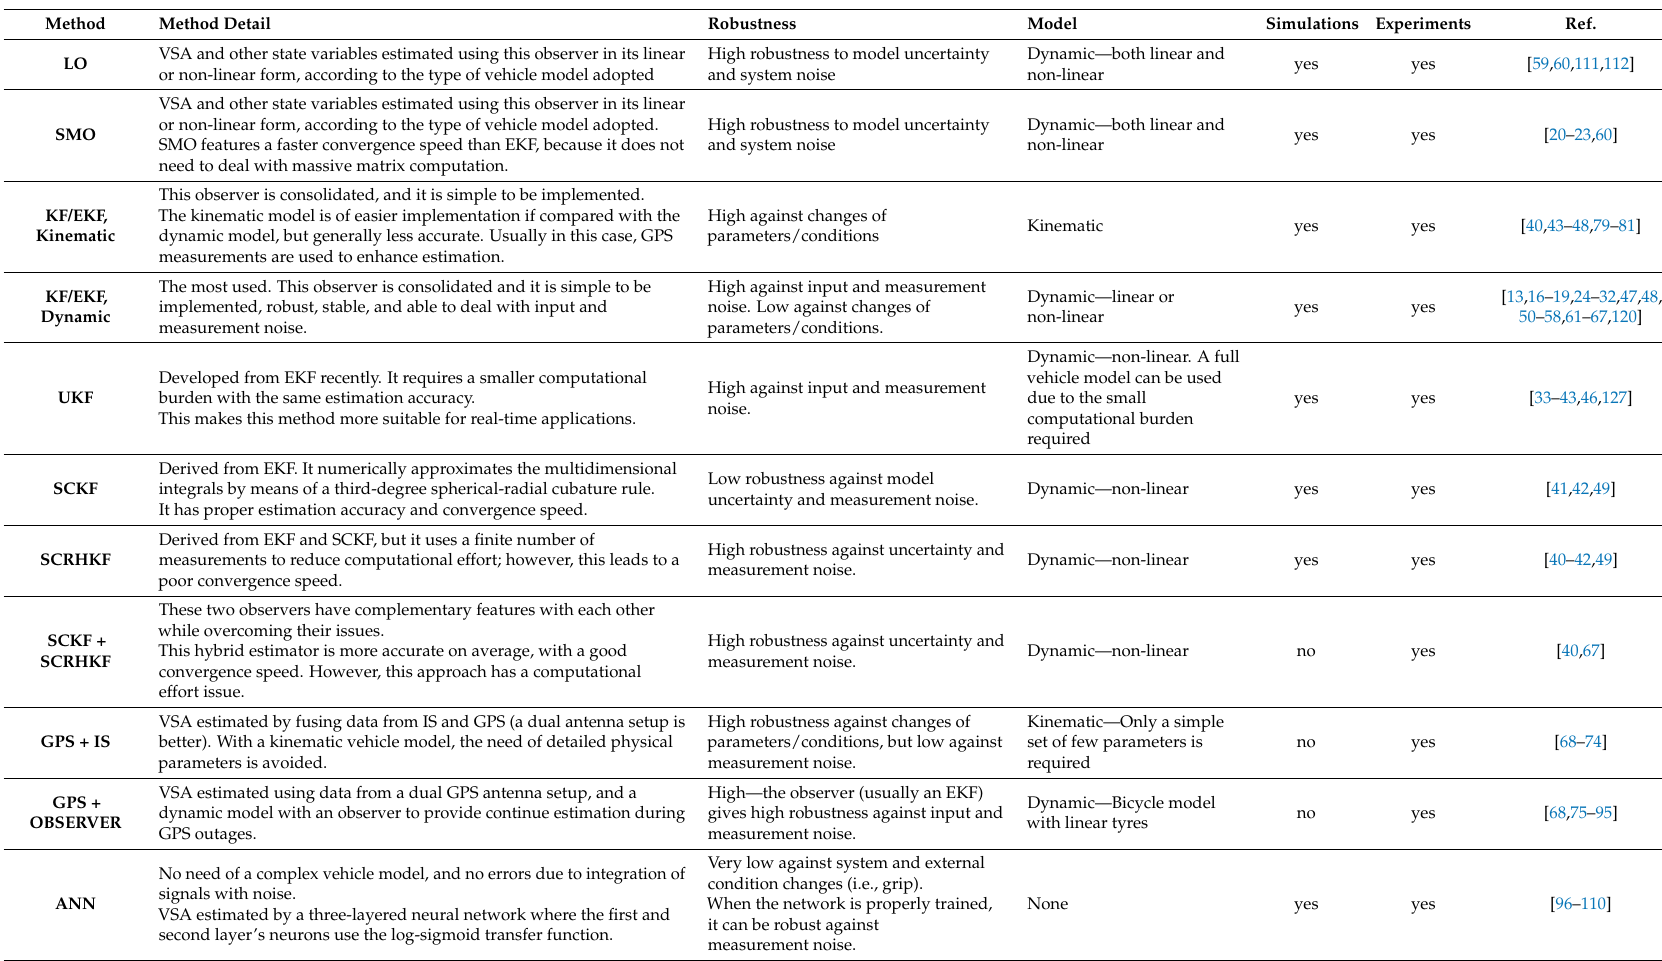
Table 1. Recap based on method and approach adopted for vehicle sideslip angle (VSA) estimation. LO: Luenberger observer; SMO: sliding-mode observer; KF: Kalman filter; EKF extended Kalman filter; UKF: unscented Kalman filter; SCKF: square-root cubature Kalman filter; SCRHKF: square-root cubature-based receding horizon Kalman filter; IS: inertial